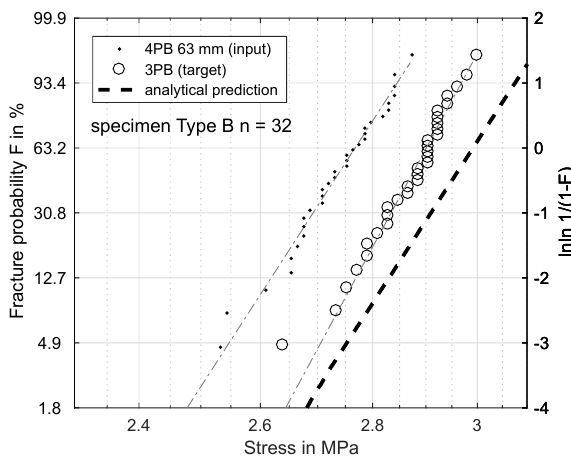
Figure 9. Specimen Type B: prediction of fracture probability from 4PB (63 mm) to